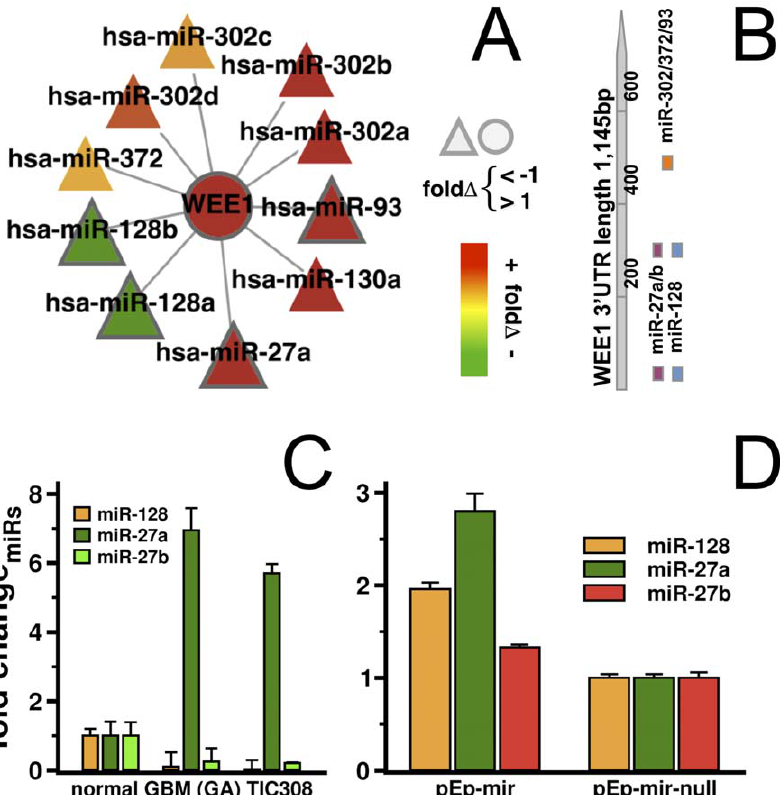
Figure 5. Significantly associated miRs of WEE1. In ( A ) we show all significantly associated interactions between the mRNA of WEE1 and miRs where miR-128ab were under-expressed (fold change FC ,2 1) and miR-27a/93 were over-expressed (FC . 1) in our GBM samples. ( B ). Corresponding miR binding sites in the WEE1 3 9 UTR are located in three main binding areas within the first 500bp from the 3 9 UTR start. Specifically, miR-128/27 have two binding sequences around nucleotides 15 and 236 while miR-302abcd/372/93 potentially recognize a common binding site around nucleotide 465. ( C ) Using RTqPCR TaqMan assays, we detected that miR-128/27b were under-expressed and miR-27b was strongly over-expressed in tumor samples. We found a similar miR expression profile in the tumor initiating/stem cell line, TIC308, where miR-128 and miR-27b kept their low expression levels. ( D ) Transfection of miR-specific expression vectors of TIC308 cells allowed the recovery of miR-128/27b levels as measured by RTqPCR.